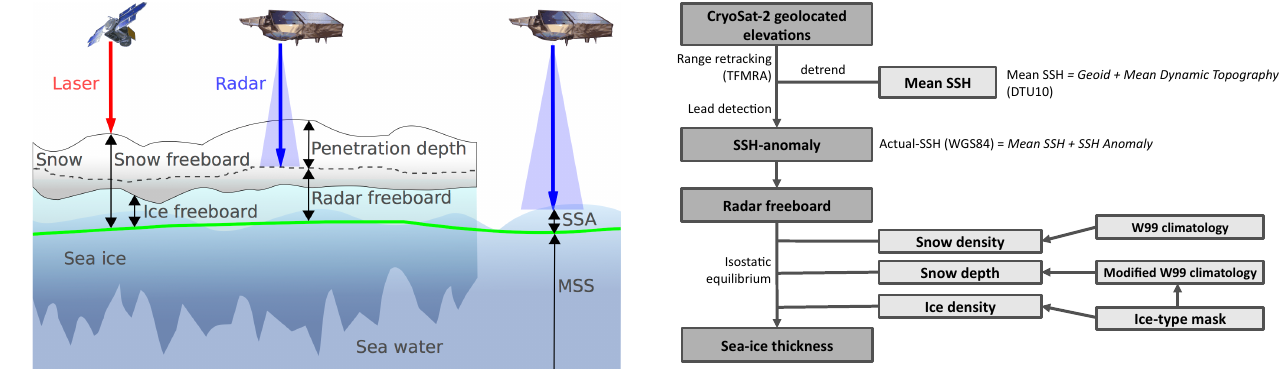
Figure 1. Schematic diagram of parameters regarding the CryoSat- 2 freeboard and thickness processing. The actual sea-surface height is composed of the mean sea-surface height (MSS) and the sea- surface anomaly (SSA). The radar freeboard is obtained by sub- tracting the actual sea surface from the range retrieval over sea ice. In contrast to a laser altimeter (e.g. IceSat), the radar altimeter of CryoSat-2 can penetrate the snow cover, depending on the snow properties.